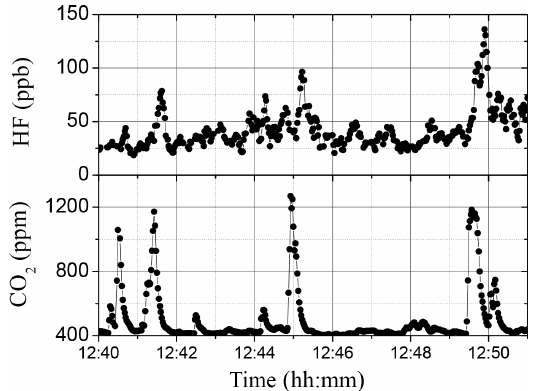
Figure 6. Allan–Werle variance plot of 1h in-flow measurements of a CO 2 calibrated mixture of about 590ppm in synthetic air, at a rate of 4Hz in two different conditions: for a pressure of 985mbar and a temperature of 295K (curve a) and for a pressure of 687mbar and a temperature of 294K (curve b).